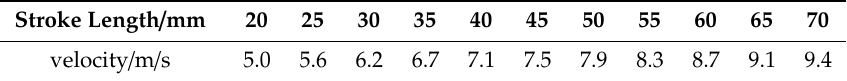
Table 2. Relationship between stroke length and velocity.